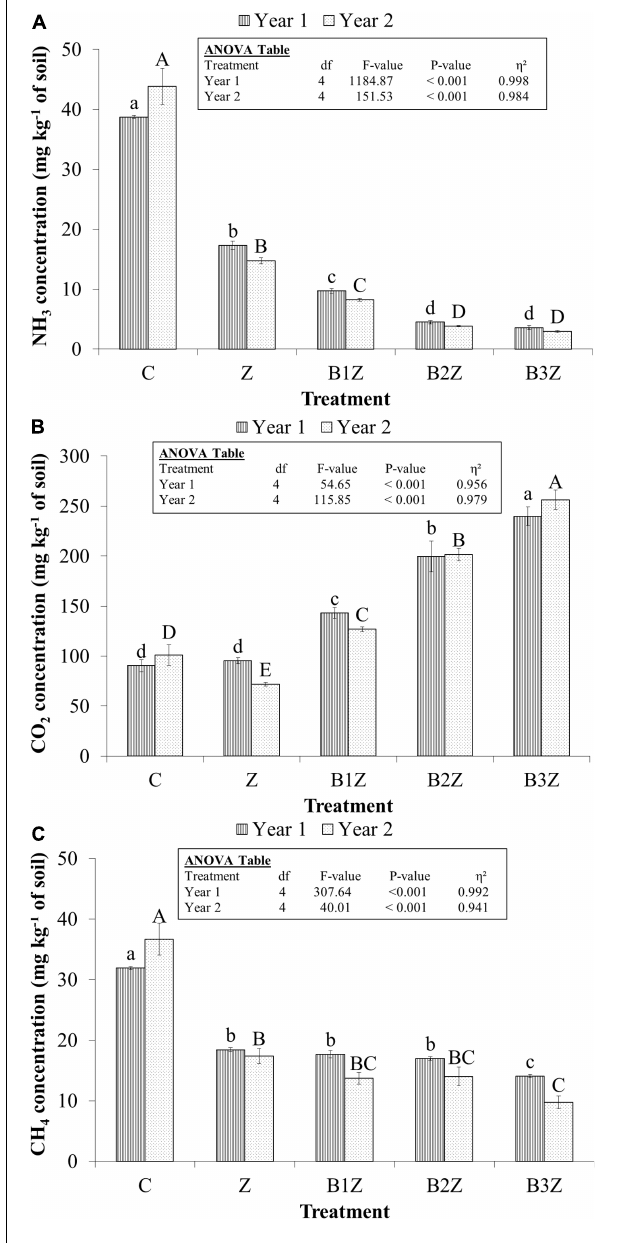
FIGURE 3 | Emissions of panel (A) NH 3 , (B) CO 2 , and (C) CH 4 from arable land after co-application of zeolite and biochar along with chemical fertilizers. Error bars represent the standard error ( ± ) of the mean. Data bars of each parameter having dissimilar small or capital letters differed significantly from each other ( P ≤ 0.05). The inset table indicates the analysis of variance (ANOVA). Multiple comparisons among treatments were analyzed by LSD